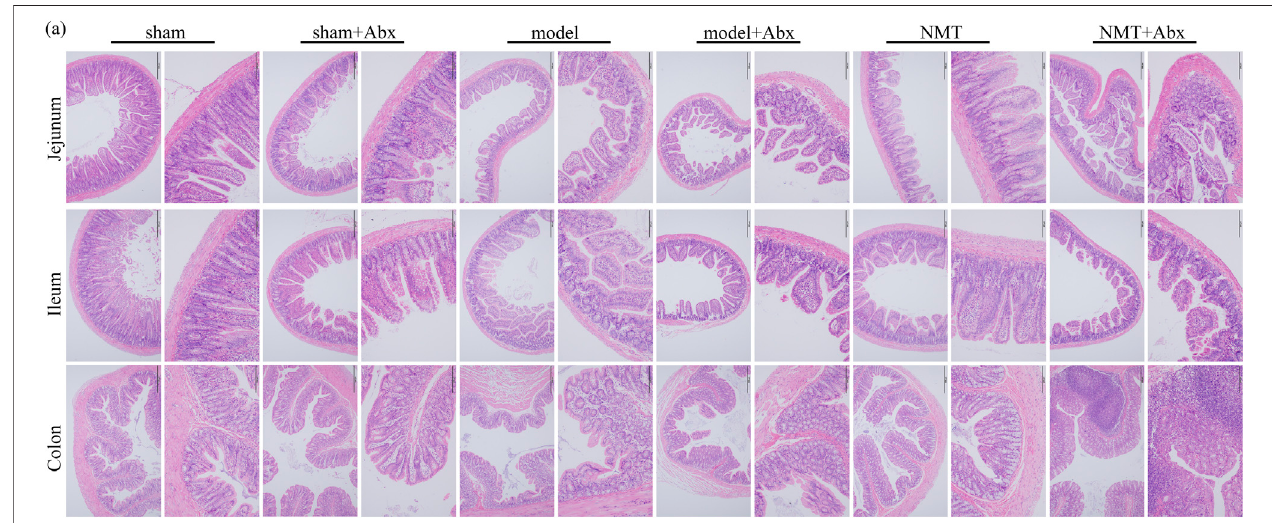
FIGURE 8 | The lack of intestinal fl ora was not conducive to intestinal barrier repair. H&E Staining of jejunum, ileum and colon (scale bar (cid:1) 200 and 100 μ m n (cid:1) 3).